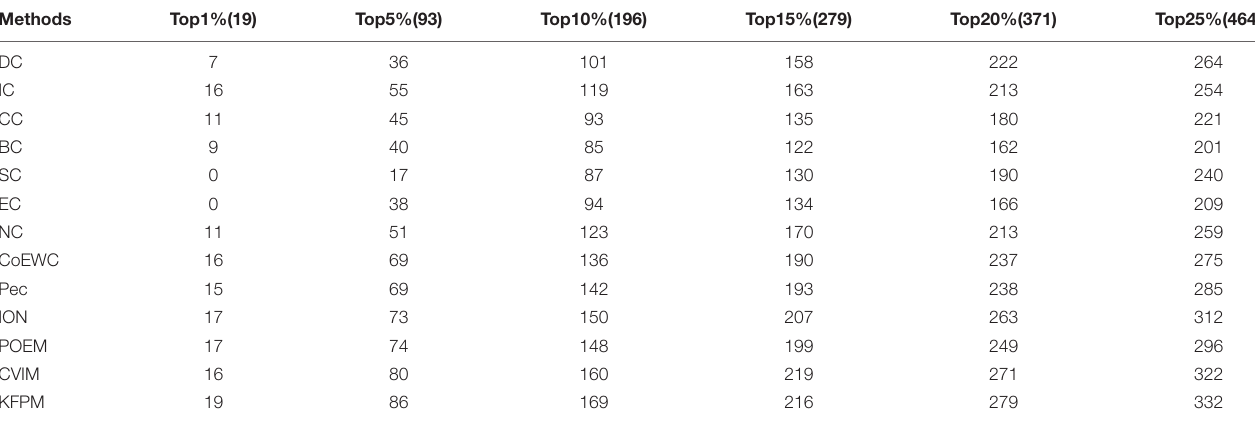
TABLE 5 | The Number of essential proteins recognized by KFPM and 13 competing methods based on the Gavin database. Methods